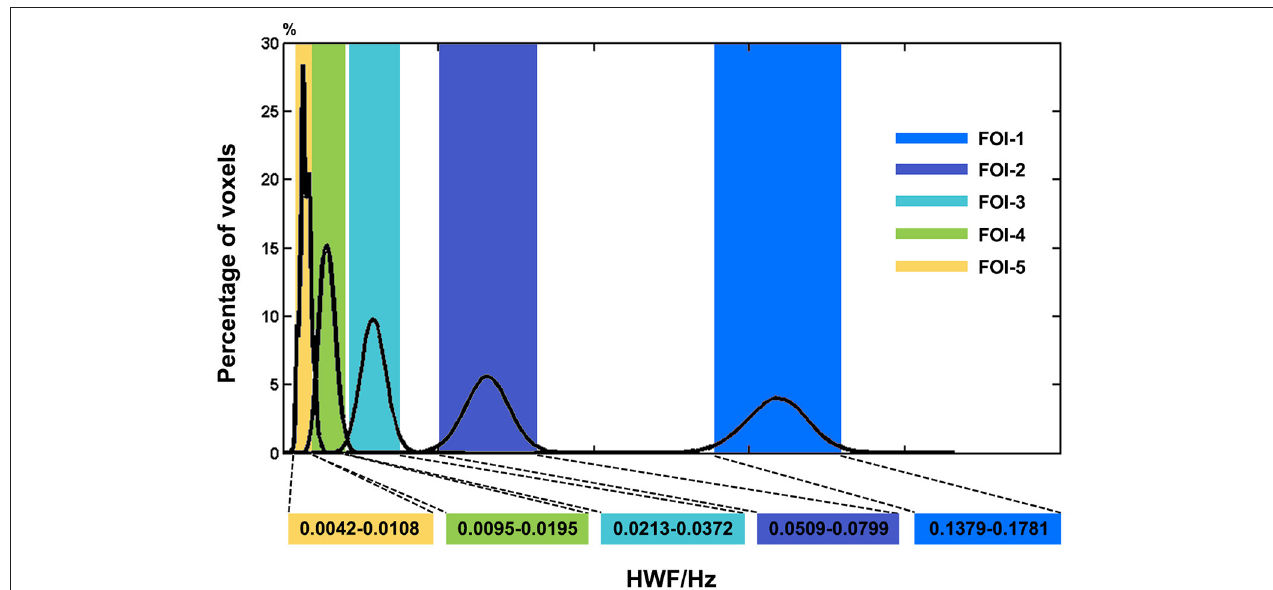
FIGURE 2 | Histogram of frequency distribution of all participants. The histograms of the HWF distributions show the first five IMFs of each voxel in the whole-brain gray matter across all participants. Each of the sub-histograms in corresponding IMFs displays amount of the whole-brain gray matter voxels within all participants. Vertical axis represents the percentage of the number of voxels with HWF equal to the frequency on the horizontal axis in the whole-brain gray matter. The rectangular bar with different colors represents the frequency bands of the final selected FOIs. Colors assigned in the sequence of blue, purple, cyan, green and yellow represent FOI-1 (0.1379–0.1781Hz), FOI-2 (0.0509–0.0799Hz), FOI-3 (0.0213–0.0372Hz), FOI-4 (0.0095–0.0195Hz), and FOI-5 (0.0042–0.0108Hz) respectively.